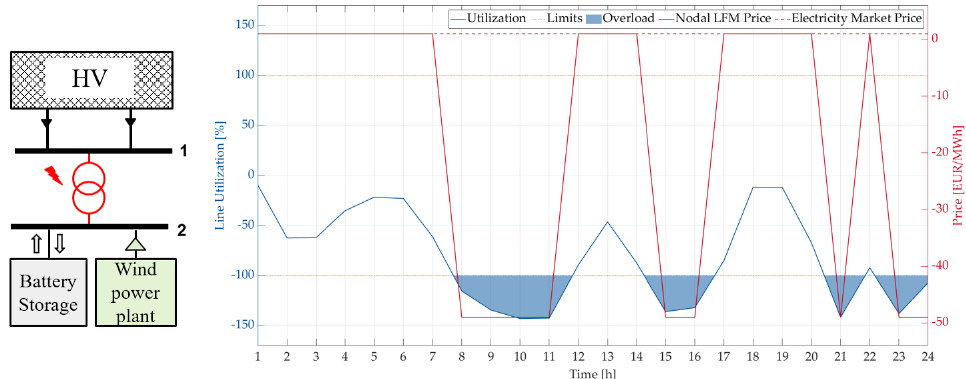
Figure 9. 2–node case study: structure, overloads and congestion